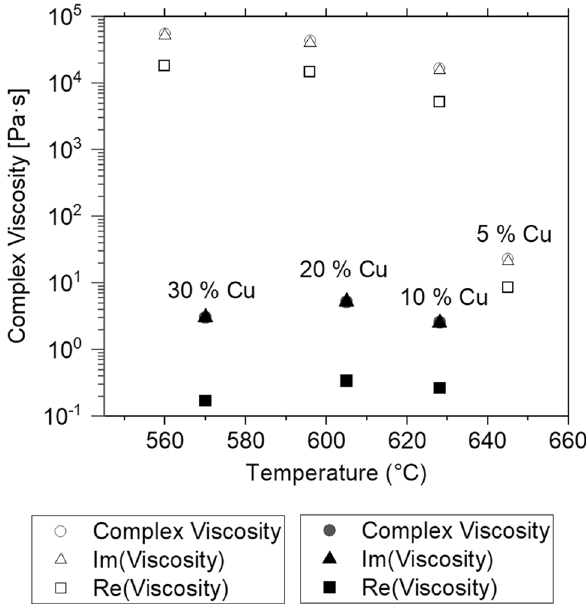
Fig. 11 Oscillatory measurements of the compositions of the liquid fractions of the 5 wt % alloy. The hollow markers are the measure- ments of the partially solidified 5 wt % alloy, and the solid mark- ers are the measurements of nominally 10, 20 and 30 wt. % alloys, which are also the compositions of the liquid portion of the par- tially solidified 5 wt. % alloy at those